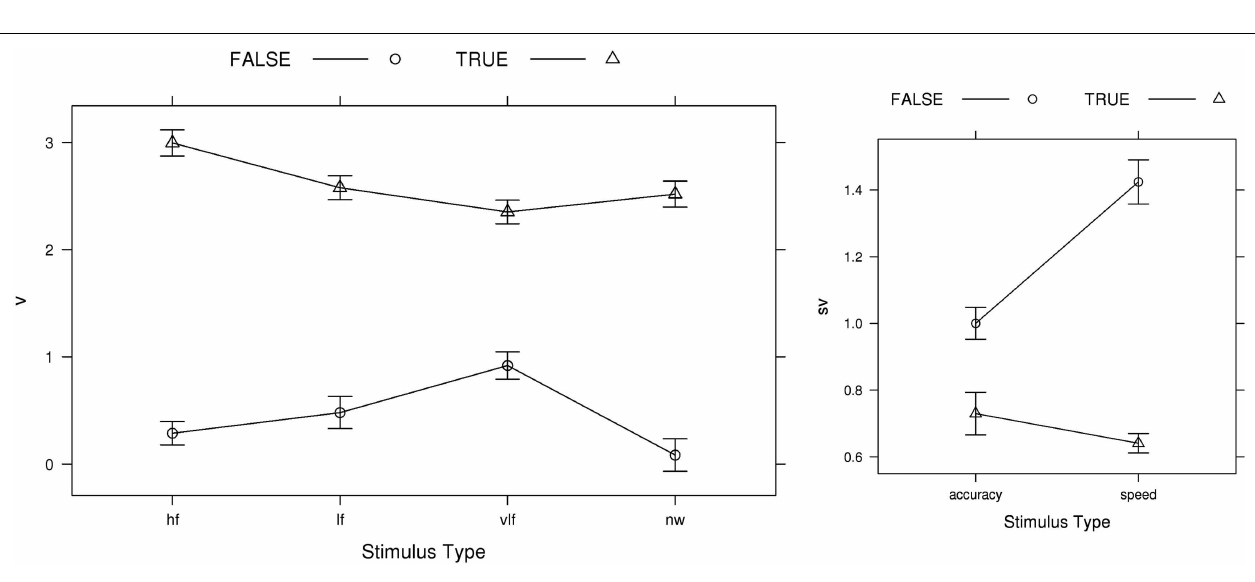
95% confidence intervals (Morey, 2008). FALSE, error-response accumulator;TRUE, correct-response accumulator; hf, high-frequency words; lf, low-frequency words; vlf, very low-frequency words; nw,